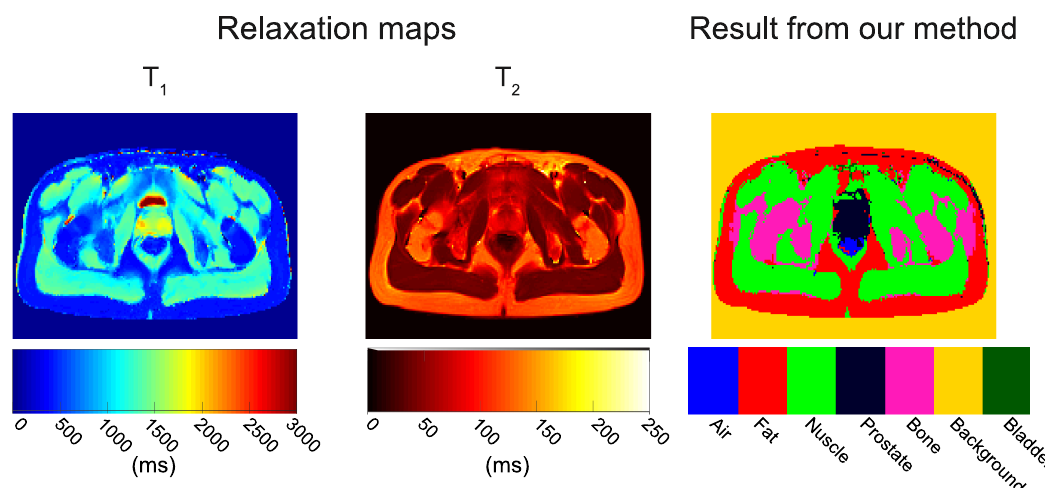
Fig 6. Relaxation maps and segmentation map of volunteer 1. Both T 1 and T 2 relaxations maps show homogeneous time values within the area of each tissue: prostate, muscle, fat, bladder and bone marrow. In the T 1 and T 2 maps, fat and bone marrow are not visually separable. The same happens in the T 2 map for prostate and fat, muscle and bladder. However, the SVM classifier accuracy is rather excellent for prostate = 99.6%, fat = 92.5%, muscle = 99.3%, and bone marrow = 96.7%. Accuracy is lower for bladder (10.4%) and air (45%) mostly because of the small size of these regions.